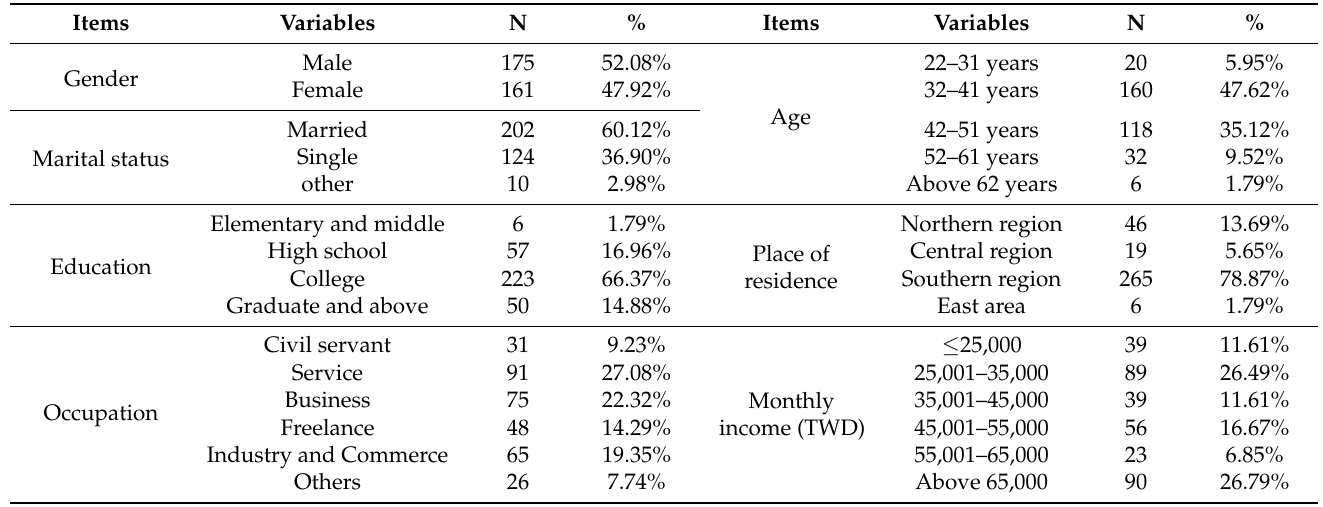
Table 1. Descriptive characteristics of the